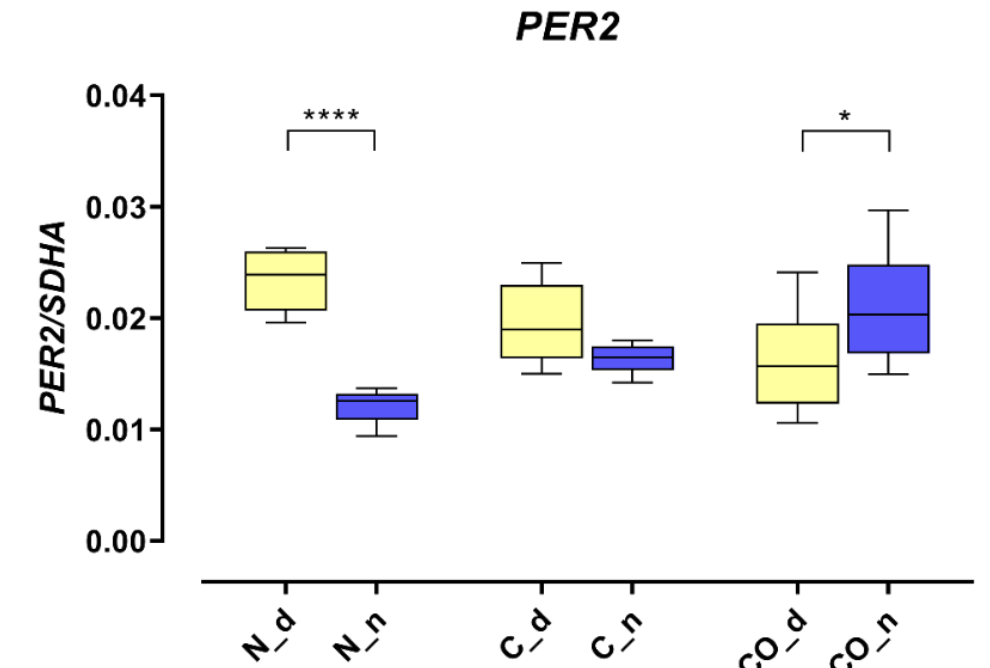
Figure 1. The PER2 mRNA expression in the preoptic part of the hypothalamus that contained suprachiasmatic nuclei in the normal (N), control (C) and CO-treated groups. The data were normalized by dividing the expression of the target gene by average expression of the housekeeping gene SDHA (succinate dehydrogenase). The bars are represented as mean ± SEM in arbitrary units. The PER2 mRNA expression obtained in the tissues of the hypothalamus during the day (yellow whisker boxes) and night (blue whisker boxes) were compared in particular studies groups. The asterisks indicate significant differences as follows: *— p < 0.05; ****— p < 0.0001.